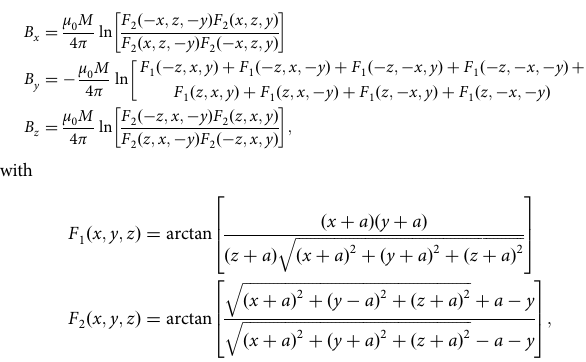
Fig. 6 Applications of the 4D programmable surface as an unusual type of dynamic 3D display system. Schematic illustration ( a ) and optical image ( b ) of the programmable surface serving as a projection screen. c Schematic illustrations and selected frames from Supplementary Movie 10 of a moving ball projected onto the surface as the shape of the surface morphs to create an illusion of actual physical interactions due to surface modulation, gravity, and inertial effects. Scale bars, 5 300 µm, height = 200 µm). Spin coating a layer of silicone elastomer (Dragon Skin 10, Smooth-On) at 1000 rpm for 30s onto the mold and curing at 75°C for 30 min yielded the channel layer (thickness = ~100 µm). Spin coating another layer of Dragon Skin at 3000 rpm for 30s and curing at 75°C for 30 min formed the capping layer (thickness = ~100µm). Both layers were treated with corona dis- charge for 2 min to facilitate bonding between them. Baking on a hotplate at 75 °C for 30 min with some applied pressure ensured strong adhesion. A laser cutting (ProtoLaser R, LPKF Laser & Electronics AG) process de fi ned the geometric outlines of ribbons (cross section width = 900µm, thickness = ~400 µm) con- taining the micro fl uidic channels (cross section width = 300 µm, height = 200 µm). Injecting liquid metal into the micro fl uidic channels completed the fabrication of the liquid metal ribbon structures.